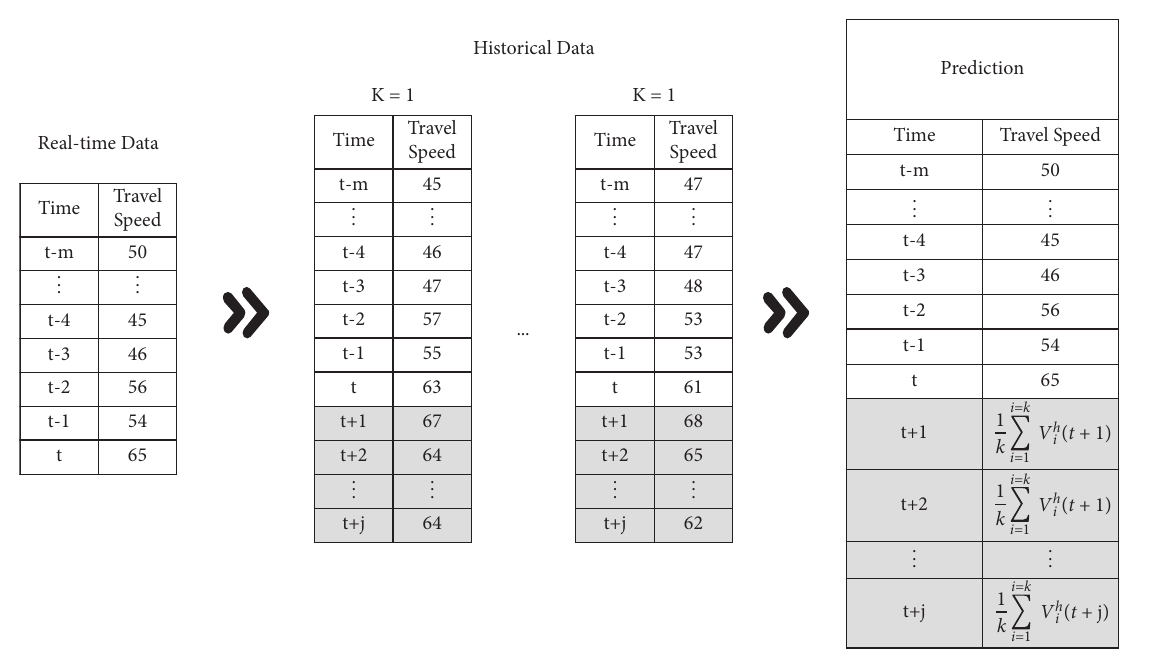
Figure 4: Speed prediction method based on Euclidean